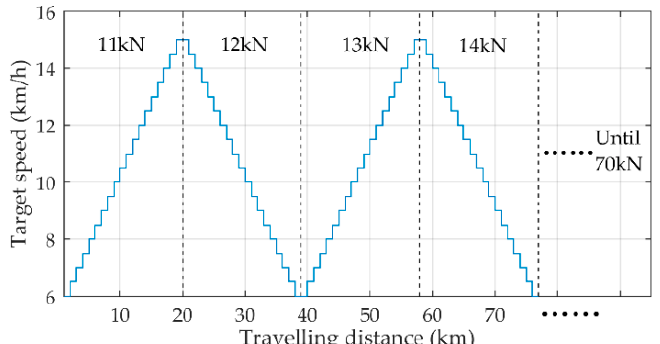
Figure 15. Travelling cycles for simulation.